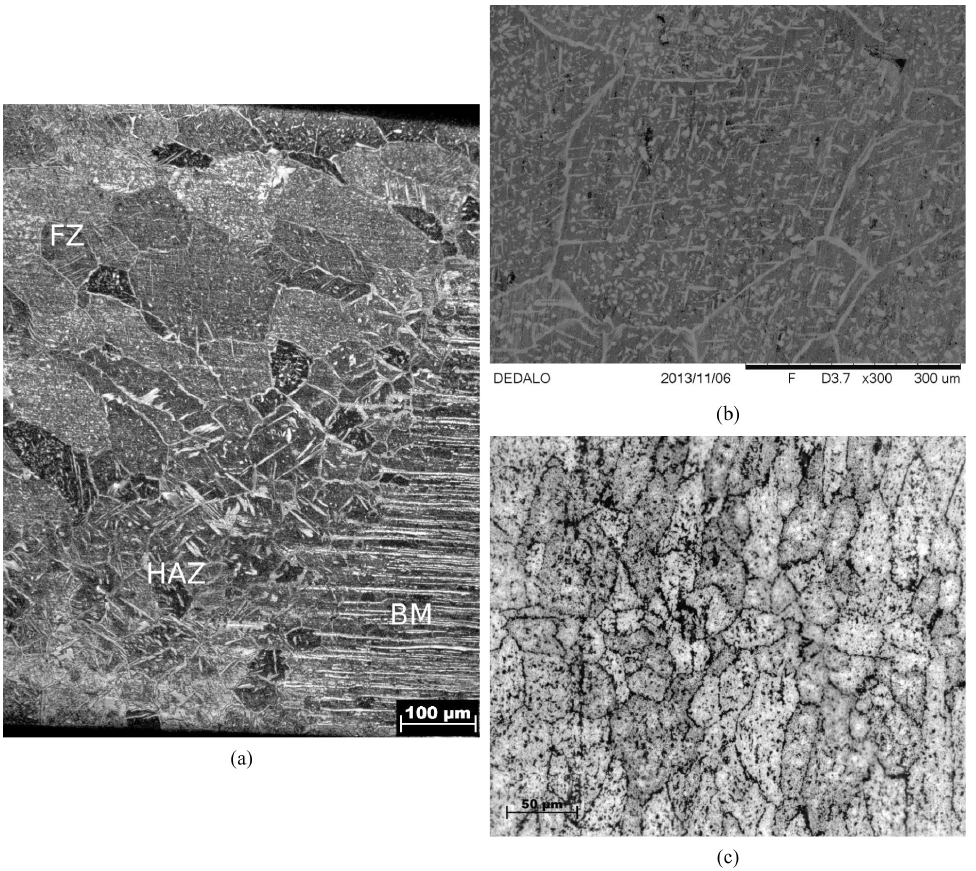
Figure 2. Microstructure of the fusion and heat affected zones in (a) TIG weld near to the heat-affected zone, (b) inside the TIG-FZ and (c) laser-FZ. Optical and scanning electron microscopy.